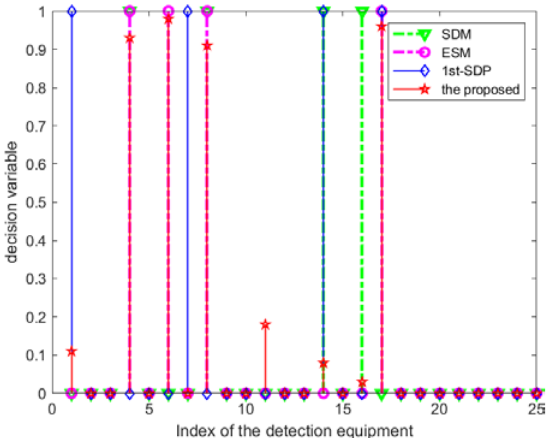
Figure 9. Comparison of node serial numbers selected by different algorithms.